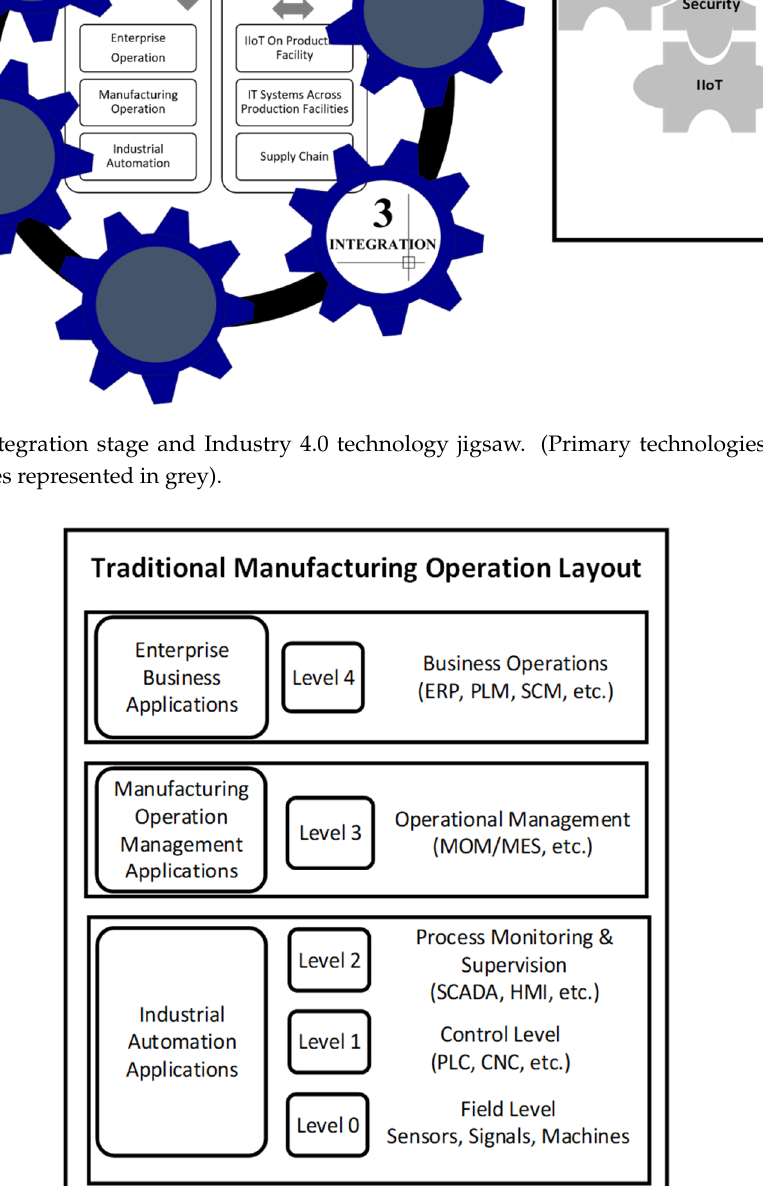
Figure 9. Traditional manufacturing operation systems layout. (Author’s creation).